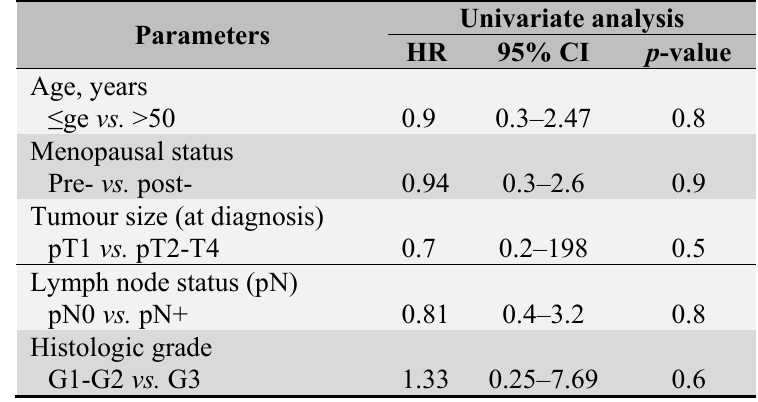
Table 2. Univariate Cox regression analysis of factors associated with disease-free survival in early triple negative breast